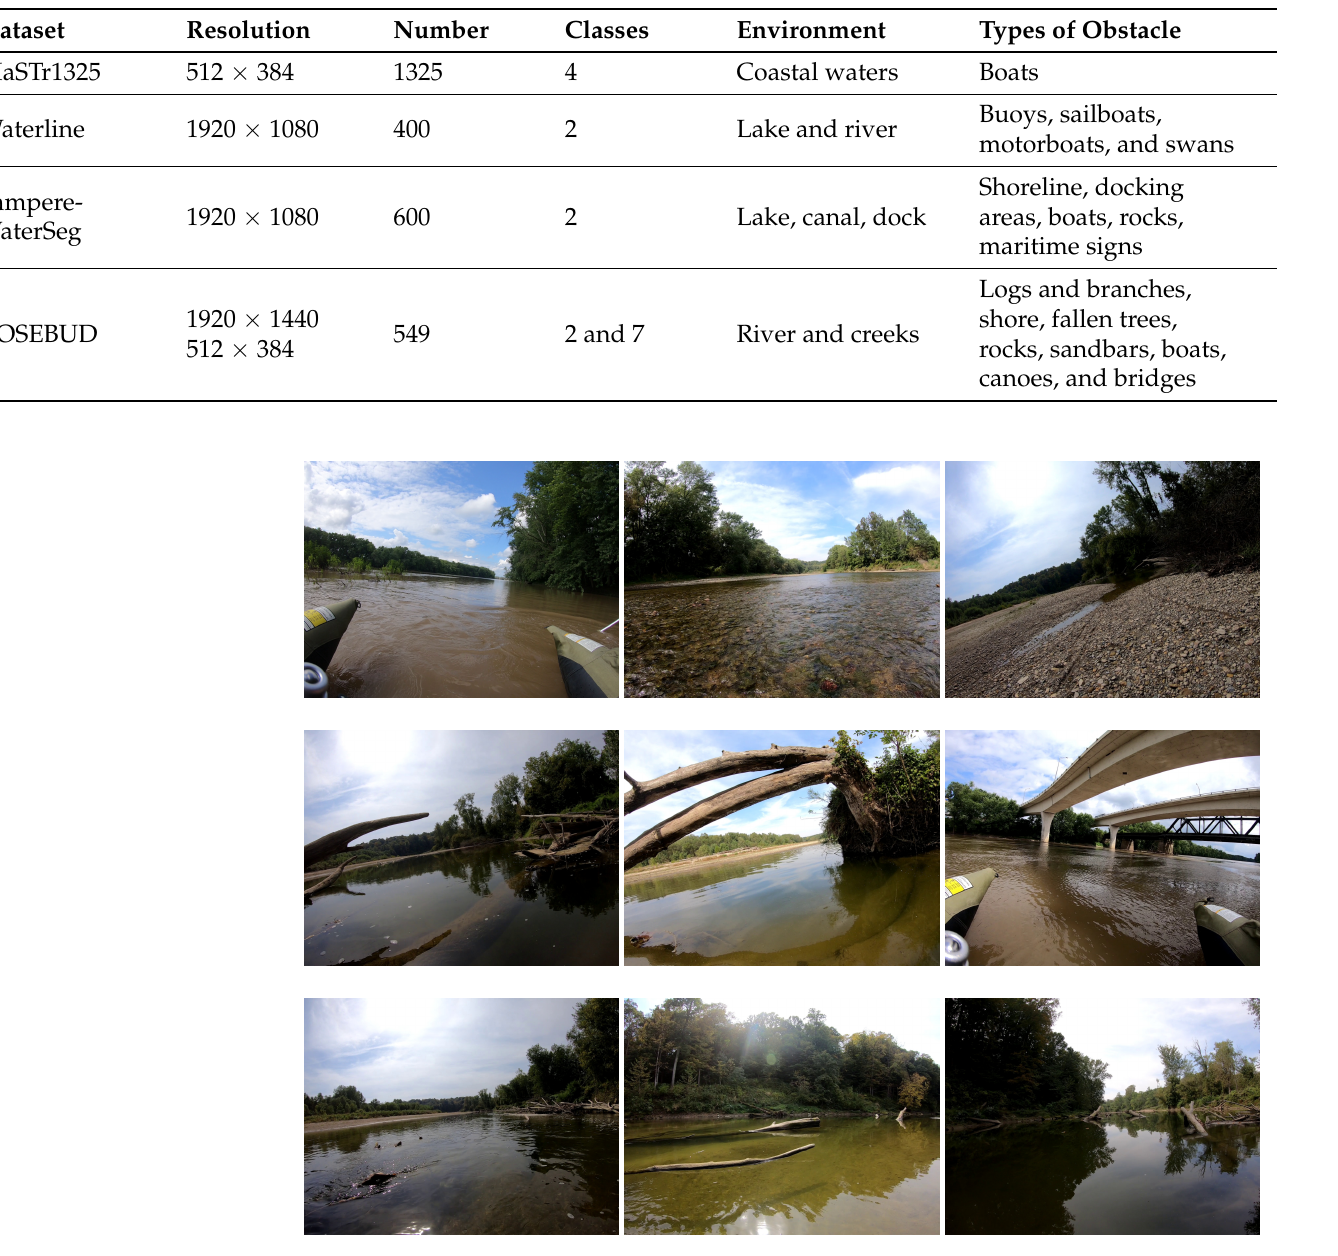
Figure 3. Examples from the ROSEBUD dataset [38] qualitatively showing variance in sizes of obstacles and